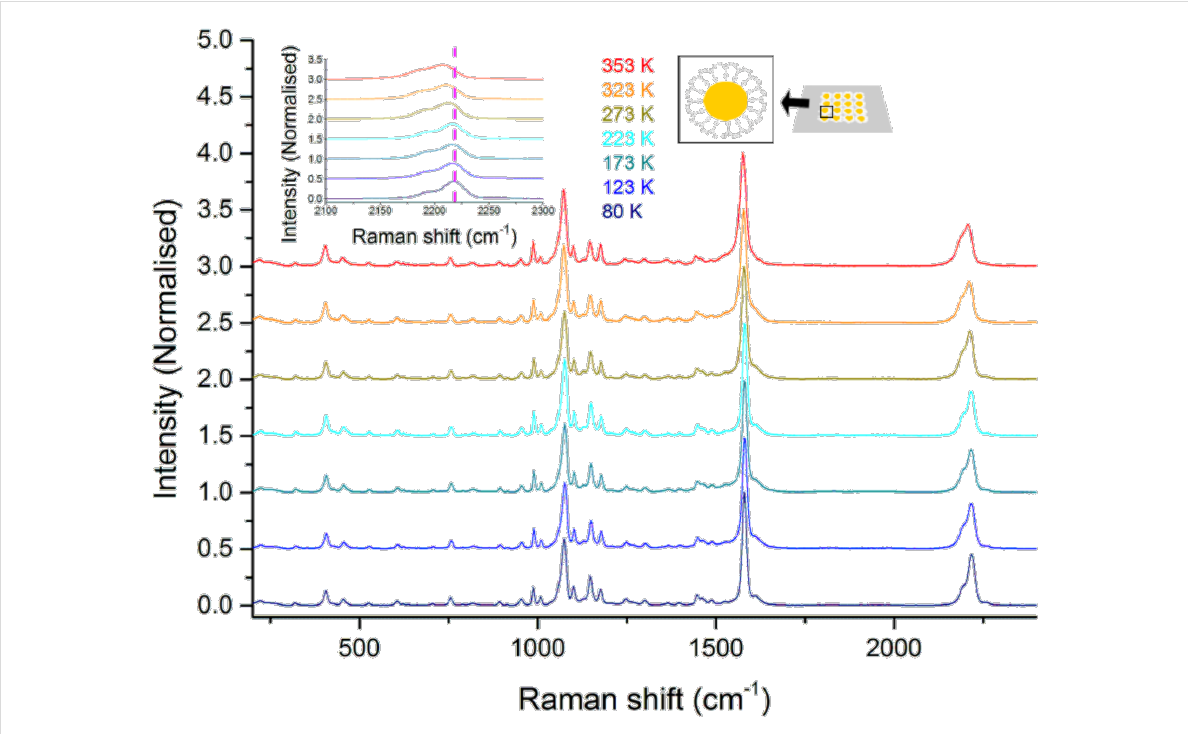
Figure 4: Temperature-dependent Raman spectra of 2D Au-NP–S-BPP arrays microcontact printed on a quartz substrate excited at 633 nm (illumi- nating power 1.2 mW at the sample). Inset: expansion of the alkyne stretch mode; the vertical marker emphasizes the temperature shifts in the